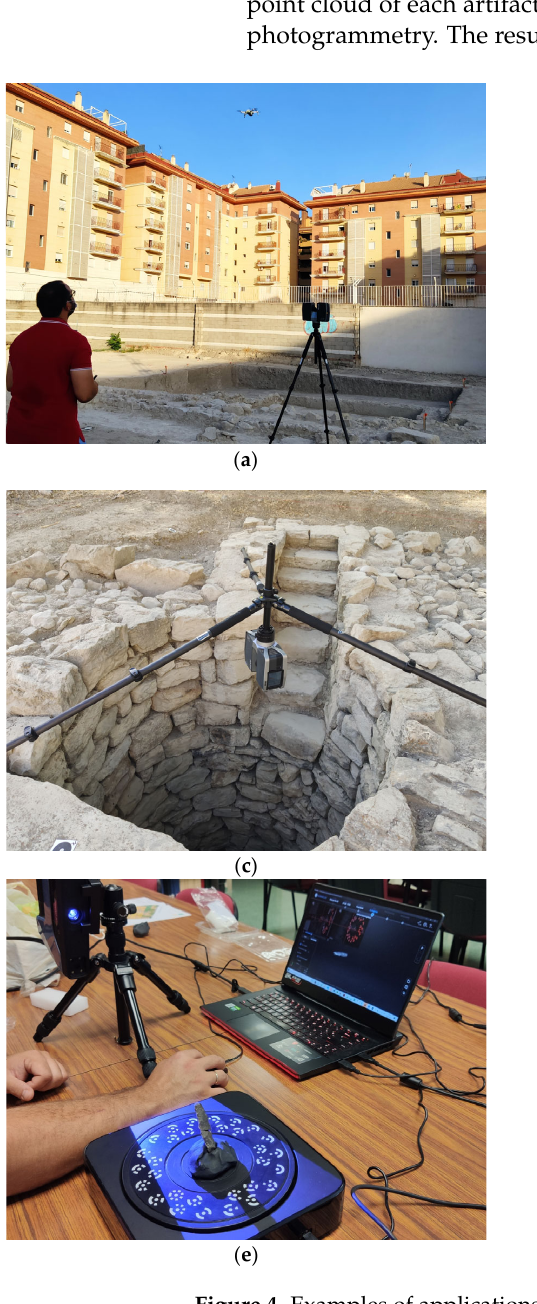
Figure 4. Examples of applications developed in this study: ( a ) RPAS and TLS acquisition (SL2–S4) of an excavation test; ( b ) CRP acquisition of a burial (SL3–S3); ( c ) TLS acquisition of a Roman